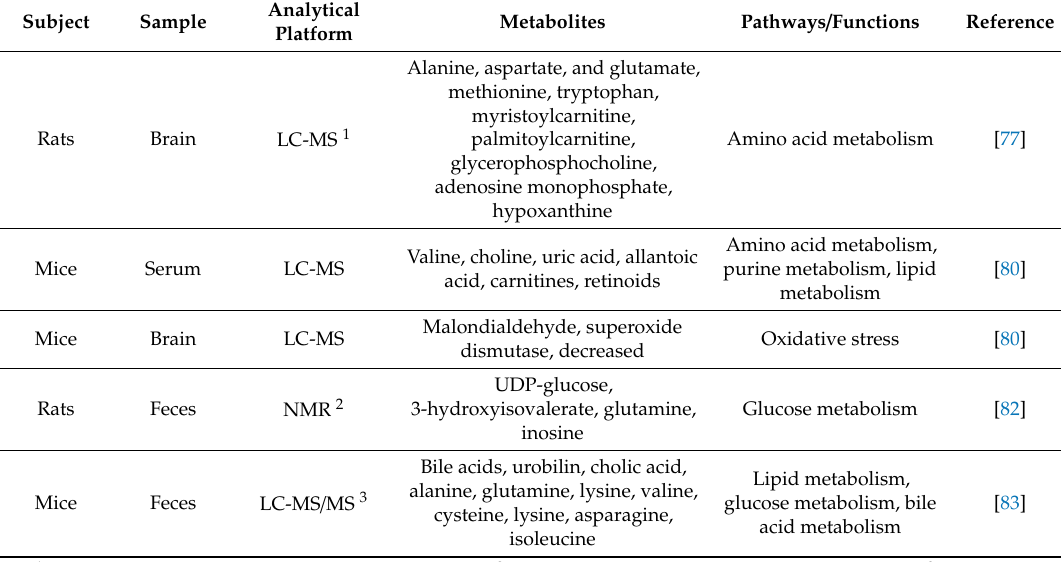
Table 4. Possible biomarkers in sleep